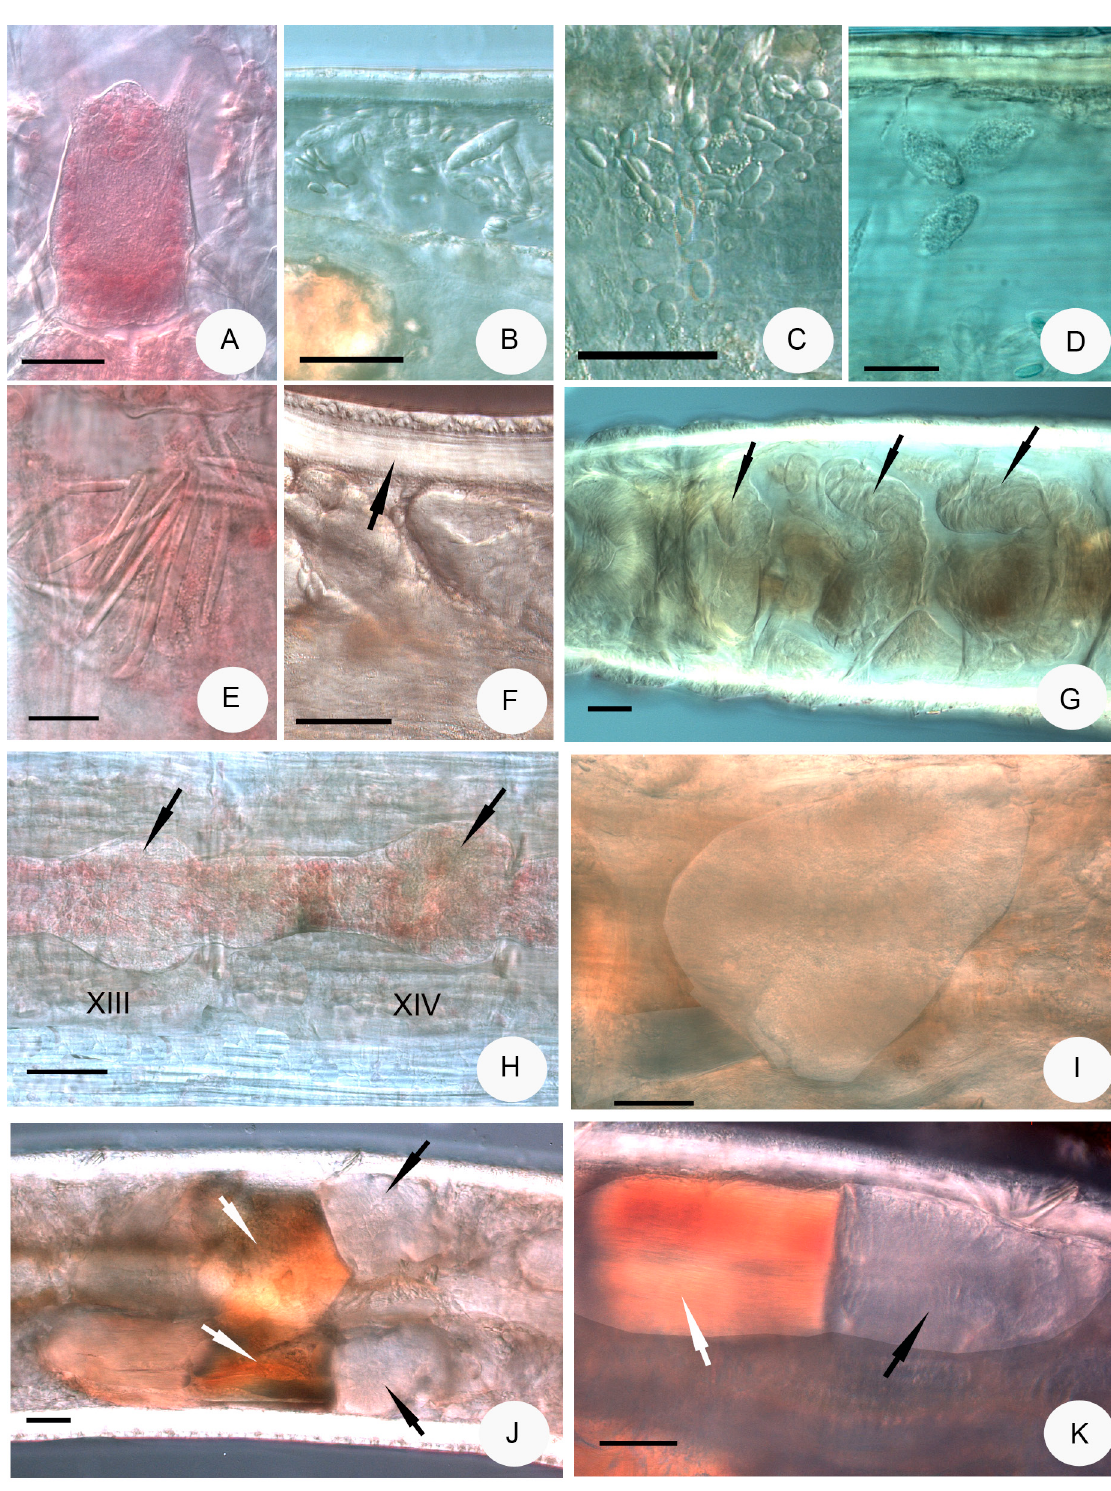
Fig. 2. Micrograph of Fridericia baradlana sp. nov. A . Brain. B – D . Coelomocytes (C. several large lenticytes). E . Detached chaetae in coelom. F . Thick body wall, thin cuticle. G . Pharyngeal glands (marked with arrows). H . Subneural glands in XIII–XIV (marked with arrows). I – K . Sperm funnels (funnel’s body marked with black arrows, sperm head marked with white arrows). (B–C, F, I–K in vivo , A, F, H fixed, stained, D, G fixed, not stained. Scale bars: 50 μm, in D 20 μm. B, E from